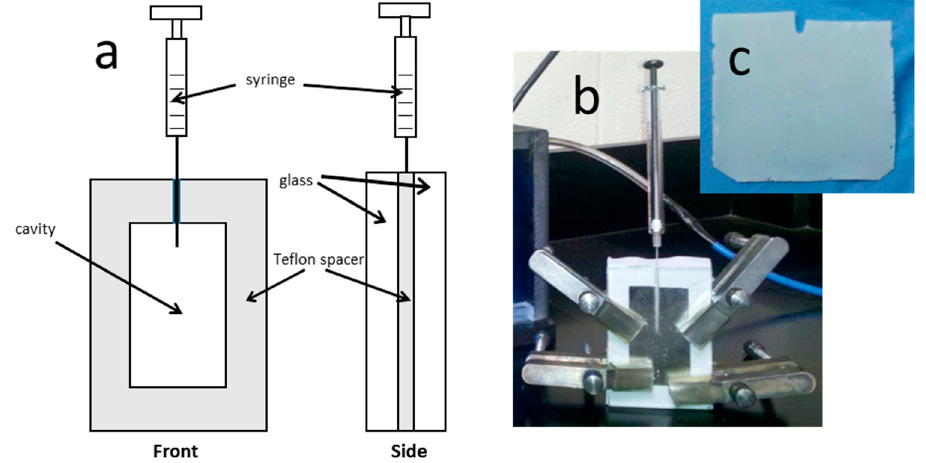
Figure 1. Schematic ( a ) and image ( b ) of the sandwich cell used for membrane fabrication via in-situ free radical polymerization. ( c ) Image of a freestanding membrane following removal from the sandwich cell.